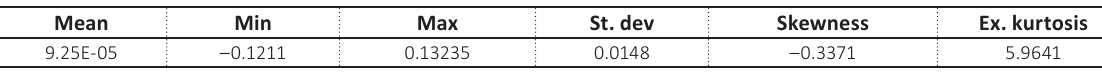
Table 2. Summary statistics